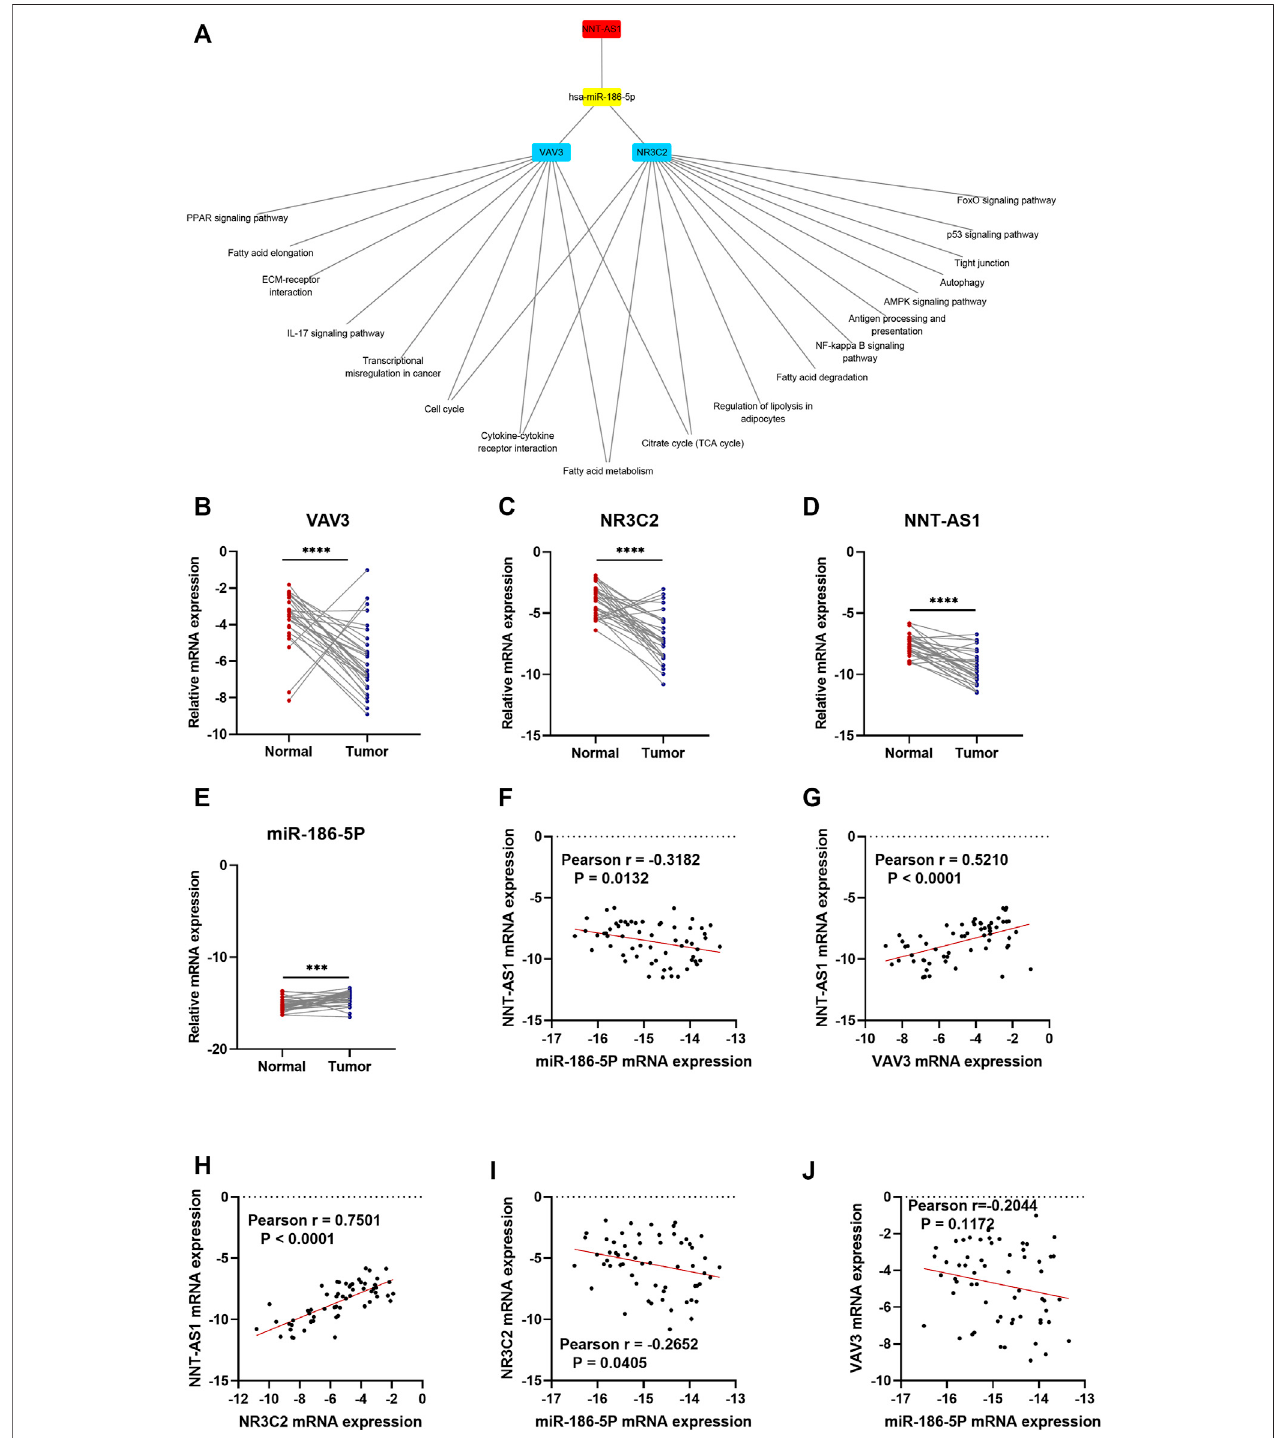
FIGURE 8 | GSEA enrichment of NR3C2 and VAV3 separately. The CeRNA network associated expression level and correlation validation by qPCR. The expression levels of NNT-AS1. (A) hsa-miR-186-5p, (B) VAV3 (C) , and NR3C2 (D) were compared between normal tissues ( n (cid:1) 30) and ccRCC tissues ( n (cid:1) 30). The correlation analysis of the ceRNA network were conducted, and the R coef fi cients were calculated (E – J) .